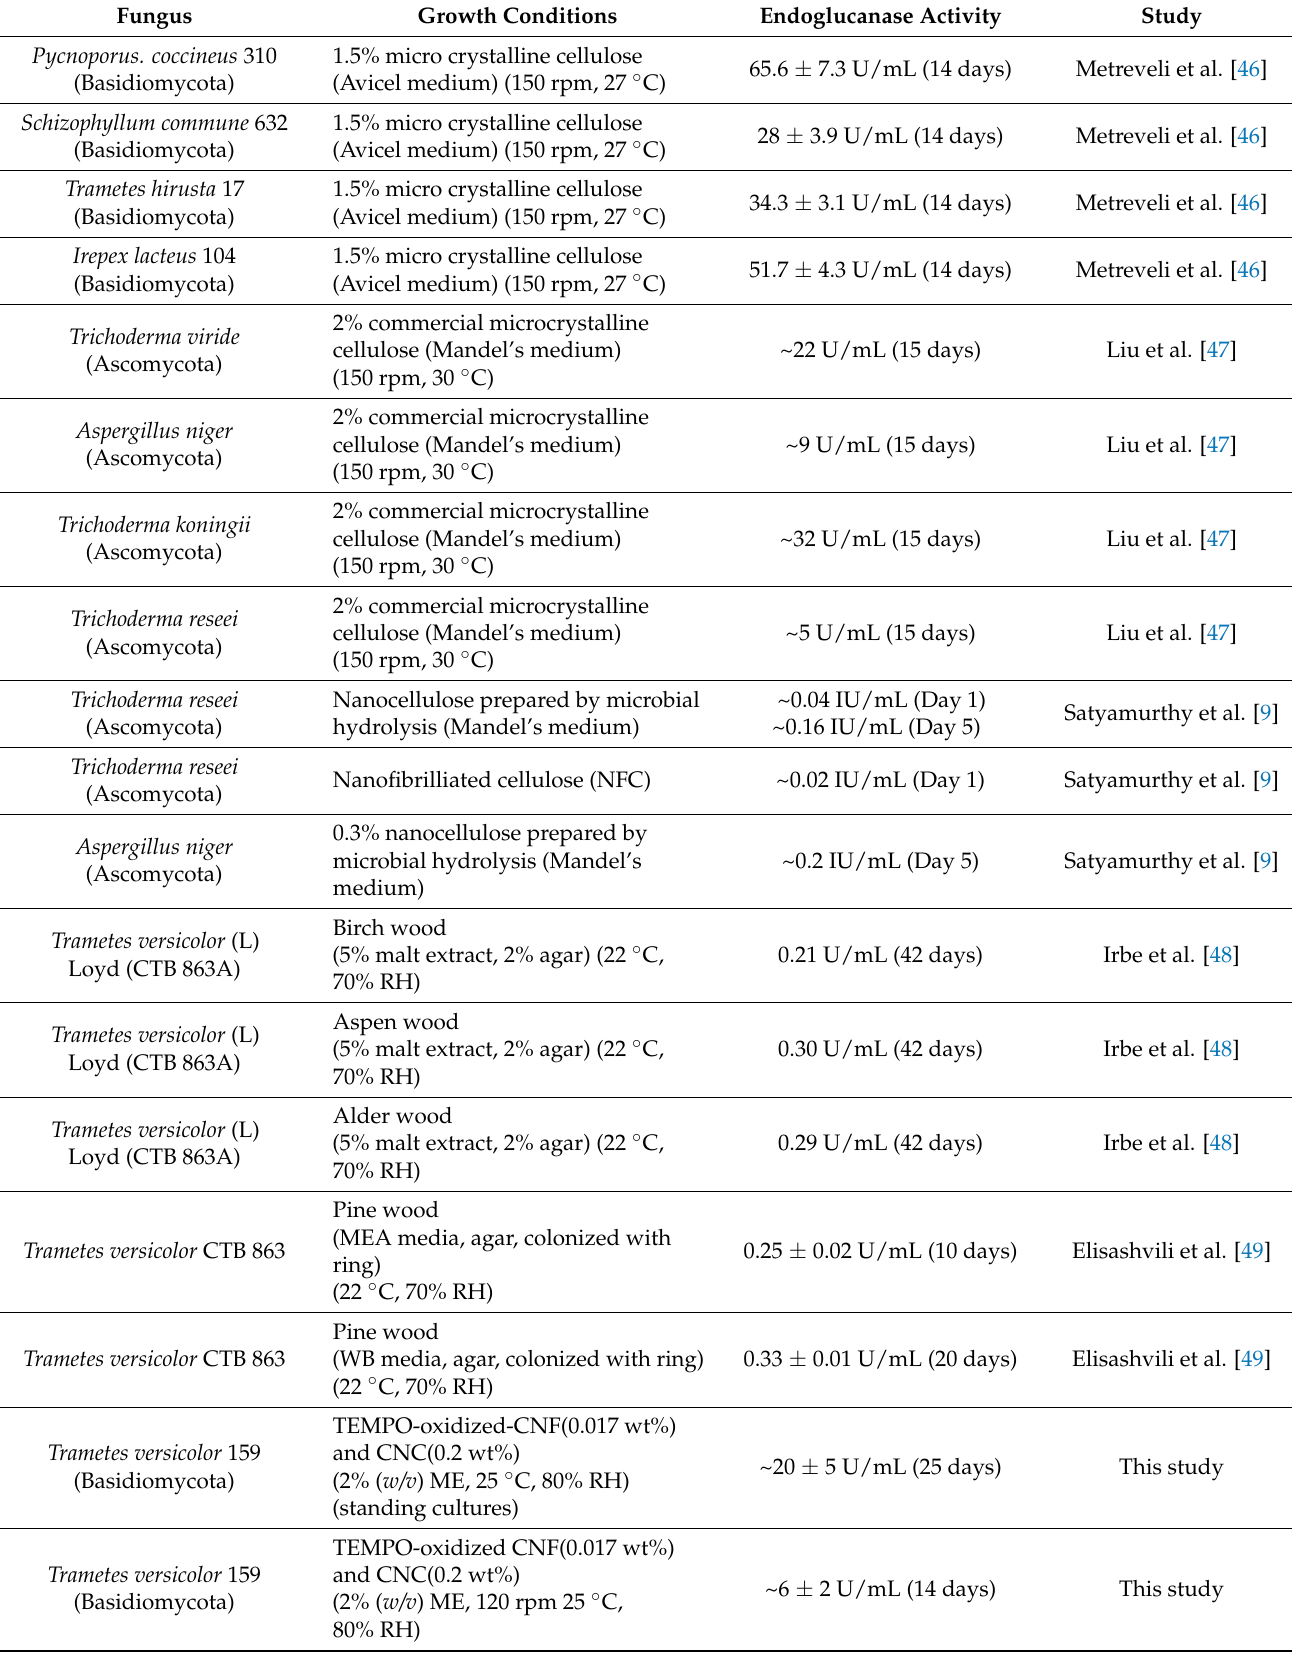
Table 1. Comparison of endoglucanase activities of fungi grown in the presence of crystalline cellulose or wood. Fungus Growth